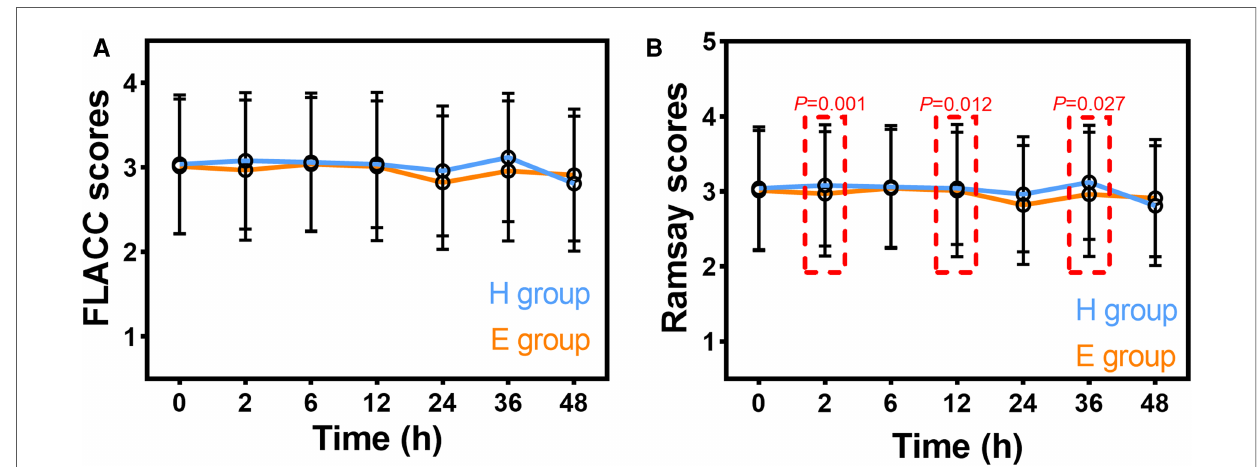
FIGURE 2 Postoperative FLACC scores ( A ) and Ramsay sedation scores ( B ) in patients receiving hydromorphone (H group) or esketamine (E group). FLACC: Face, Legs, Activity, Cry, Consolability scale. Data are mean±standard deviation.